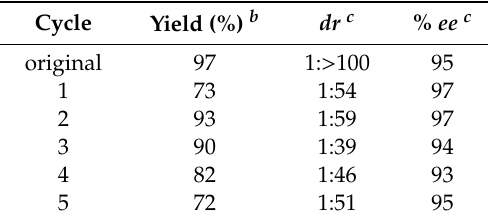
Table 3. Recycling of P1 a